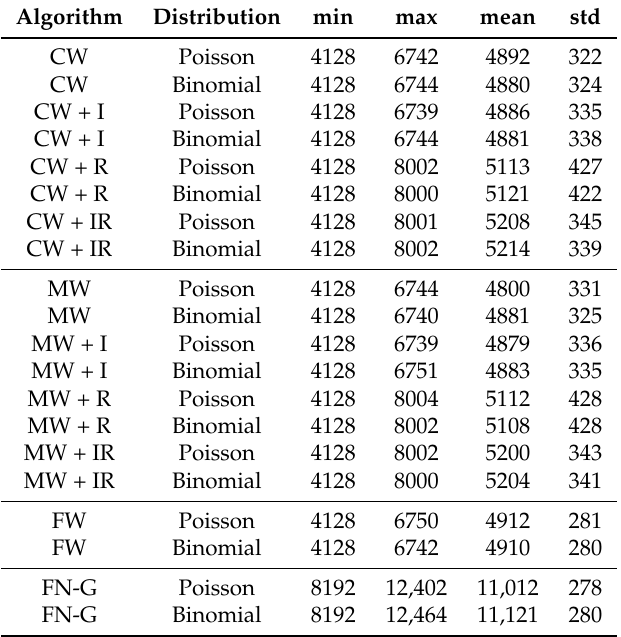
Table 4. Performance in terms of memory (rounded in